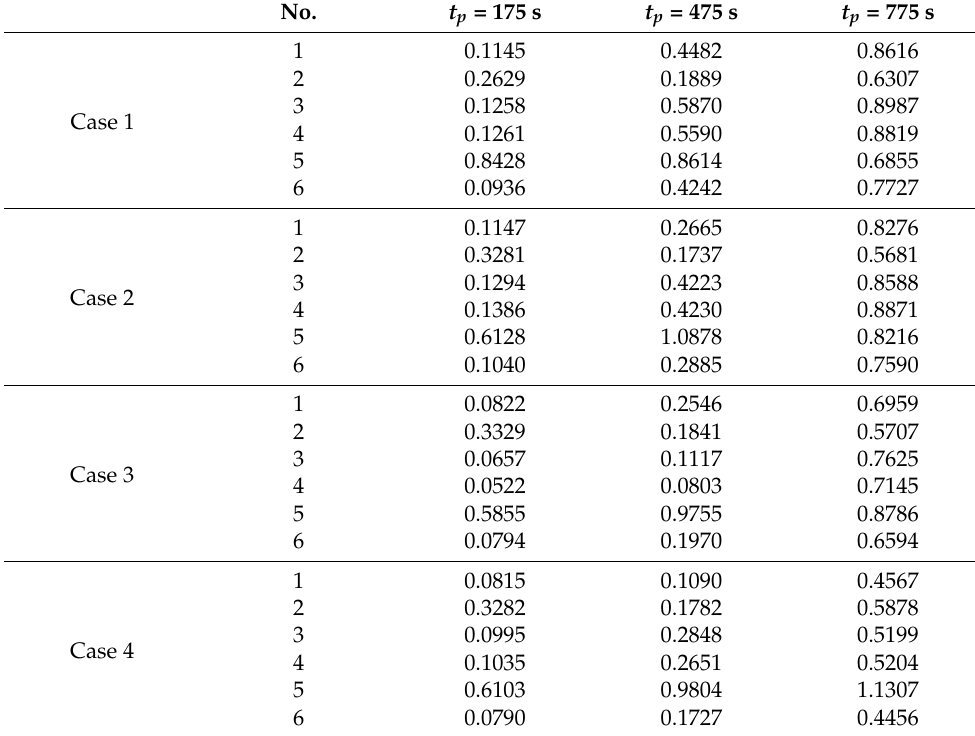
Figure 7. The position changing of the six boundary points. Table 5. The relative errors of the six boundary